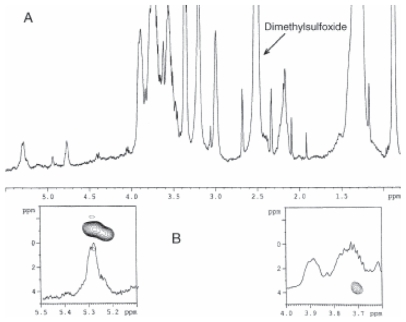
(A) 1H NMR spectrum and (B) 1H, 31P HMQC spectrum of de-O-acylated lipid A from Pseudomonas reactans.